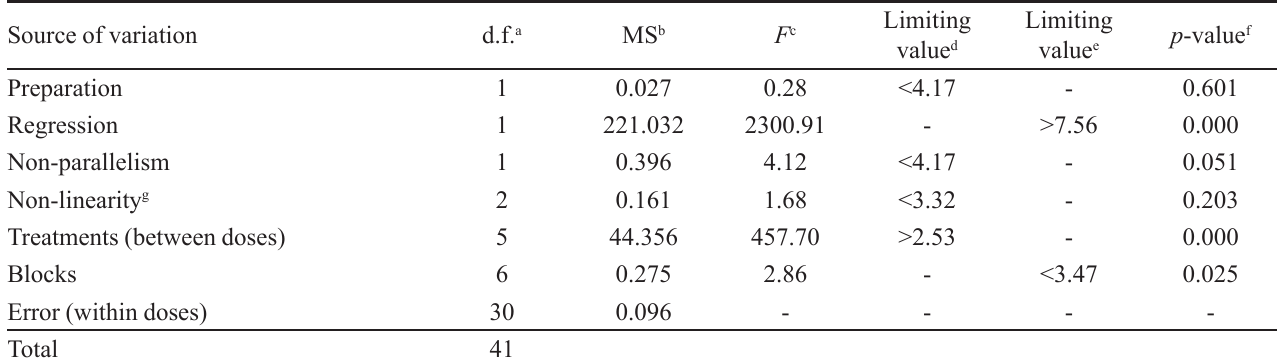
TABLE VI - Analysis of variance (ANOVA) for the ofloxacin microbiological assay according to the British Pharmacopoeia (BP) and the European Pharmacopoeia